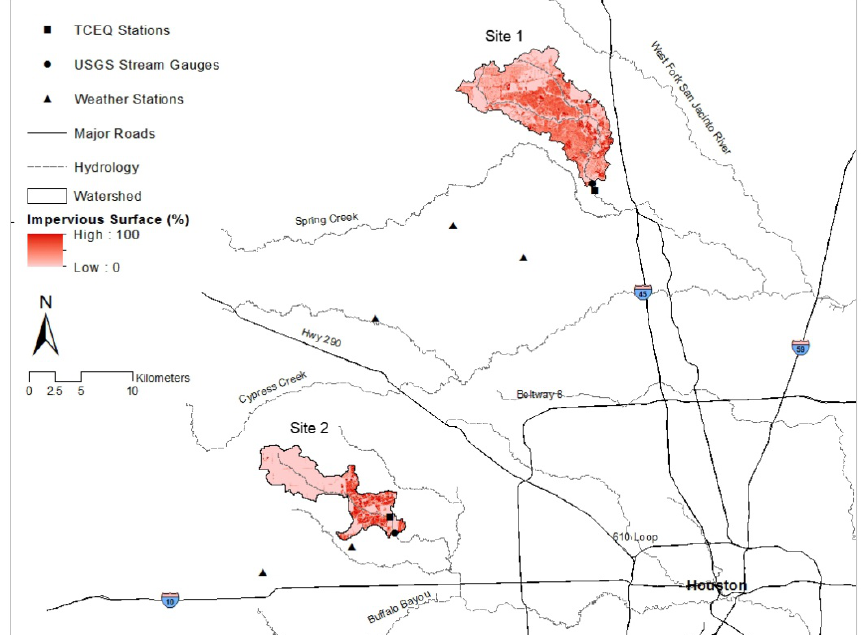
Figure 1. Study sites Panther Creek watershed (Site 1 The Woodlands green infrastructure development) and Bear Creek watershed (Site 2 conventional development) in